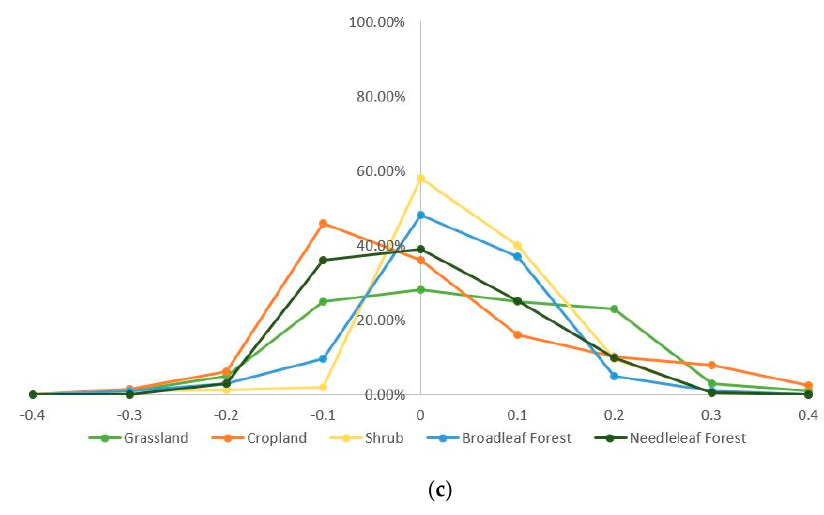
Figure 6. The difference frequency distribution between FY-FPAR and FPAR products (2014). ( a )–( c ) are the difference frequency between FY-FPAR and MODIS-FPAR; FY-FPAR and GEOV1-FPAR; and FY-FPAR and GLASS-FPAR, respectively.